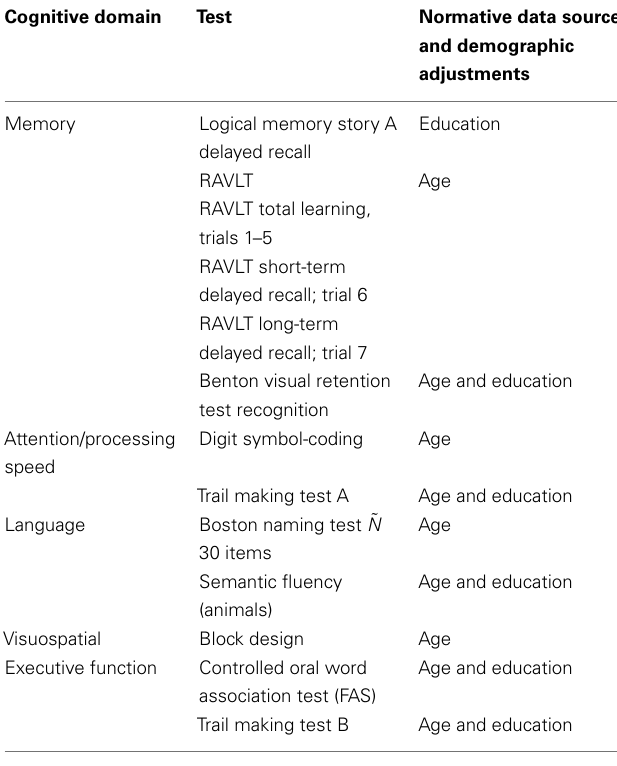
Table 2 | Neuropsychological tests used for MCI classifications